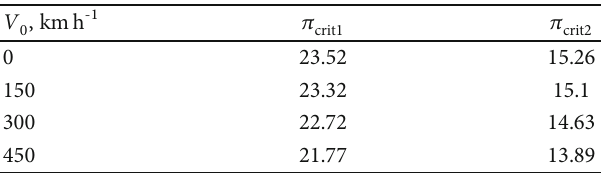
Table 5: Variations in optimum compressor pressure ratios π crit1 and and π opt2 with T 4 ∗ .